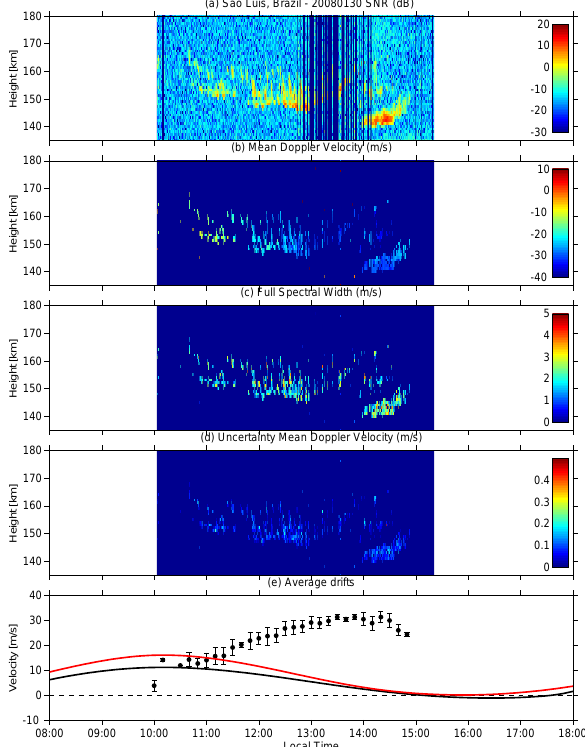
Fig. 2. (a) range–time–intensity (RTI) map of 150km echoes ob- served by the São Luís radar on 30 January 2008. The vertical dark blue lines indicate data gaps caused by interference. (b) Mean Fig. 2. (a) Range-Time-Intensity (RTI) map of 150-km echoes observed by the S˜ao Lu´ıs radar on January 30, 2008. The vertical dark blue Doppler velocity of the echoes. (c) Full spectral width of the echoes. linesindicatedatagapscausedbyinterference.(b)MeanDopplervelocityoftheechoes.(c)Fullspectralwidthoftheechoes.(d)Uncertainty in the mean Doppler velocity. (e) The solid lines show the model prediction of vertical plasma velocities for S˜ao Lu´ıs(black) and Jicamarca (d) Uncertainty in the mean Doppler velocity. (e) The solid lines (red). The markers show the estimated mean Doppler velocity of the 150-km echoes observed by the S˜ao Lu´ıs radar. The 3-hour Kp indices show the model prediction of vertical plasma velocities for São Luís for this day are: 1, 2-,0, 0+, 0, 0,0, 0. (black) and Jicamarca (red). The markers show the estimated mean Doppler velocity of the 150km echoes observed by the São Luís radar. The 3h Kp indices for this day are 1, 2 − , 0, 0 + , 0, 0, 0,